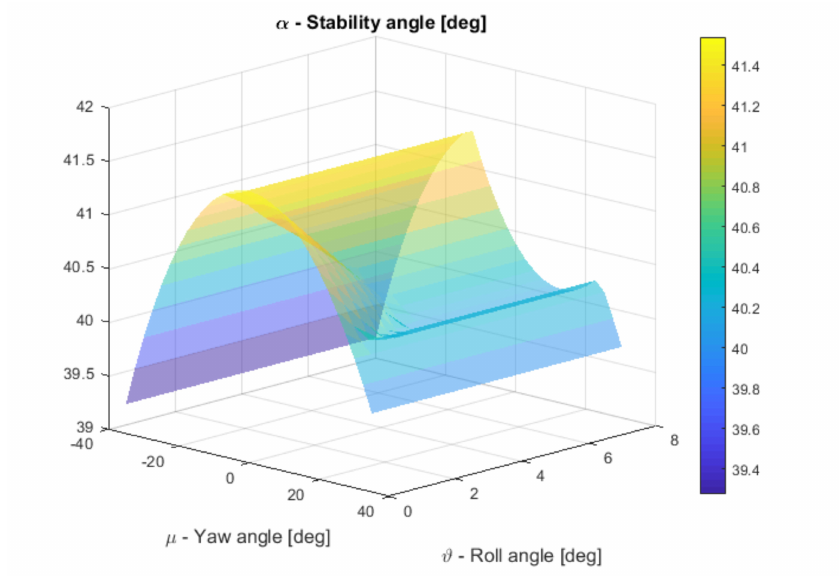
Figure 8. The foreseeable stability angles of the whole tractor vs. Yaw angle and Roll angle.